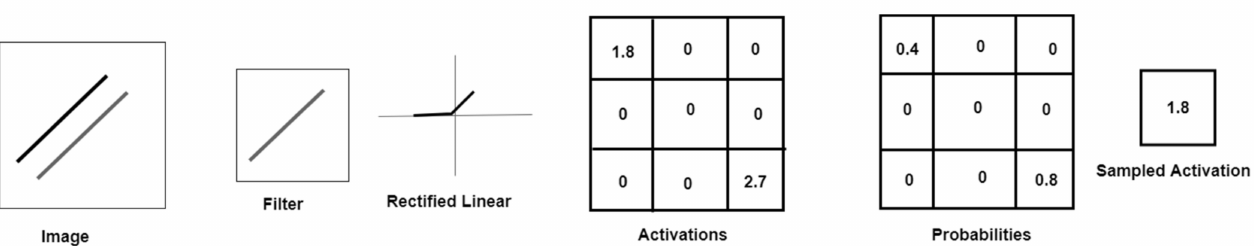
Figure 4. Stochastic pooling: a random sample is selected from a multinomial distribution of activations based on probabilities estimated by normalizing the activations. The chance of being selected increases with the size of the activation. In this figure, there are two activations, 1.6 and 2.4, with probabilities of 40% and 60%, respectively. However, 1.6 was chosen as the sampling activation despite the high probability of 2.4. Stochastic pooling can lose essential features because there is no way to predict which part of the input will be selected. Enhanced and regenerated from